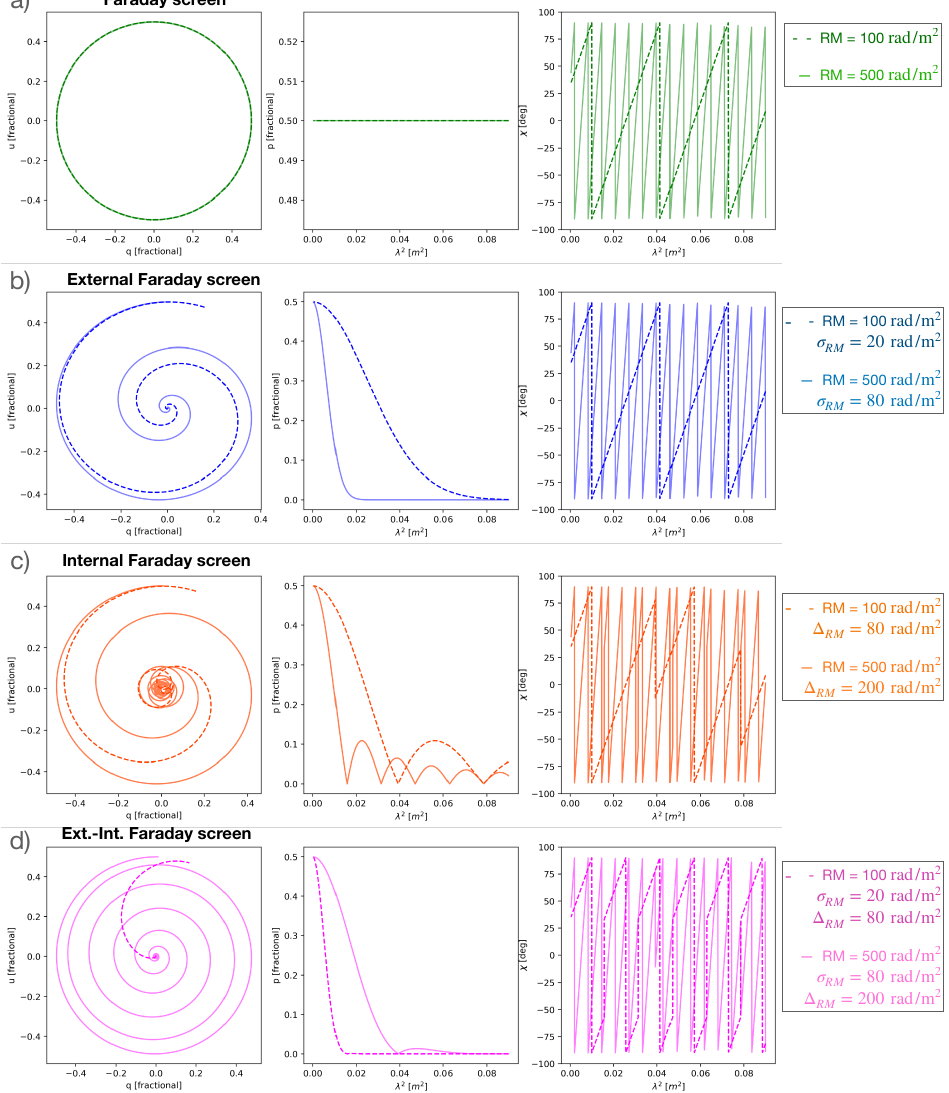
Figure 1. Representation of de/polarization models: ( a ) Equation (6), Faraday rotation (only one Faraday component does not depolarize the emission); ( b ) Equation (7), External Faraday depolarization (considering turbulent magnetic field); ( c ) Equation (9), Internal Faraday depolarization (considering regular magnetic field, only); ( d ) Equation (11), Mixture of Internal and External Faraday depolarization. Comparison between the behaviors of low and large RM values and low and large σ RM and ∆ RM are represented by dashed and straight lines, respectively. The used values of RM, σ RM and ∆ RM , are reported in the labels on the right side of the